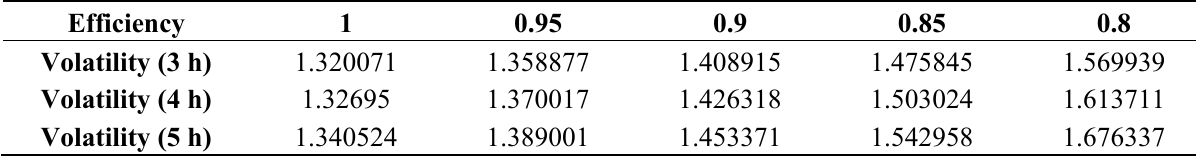
Table 4. Efficiency, operation duration and